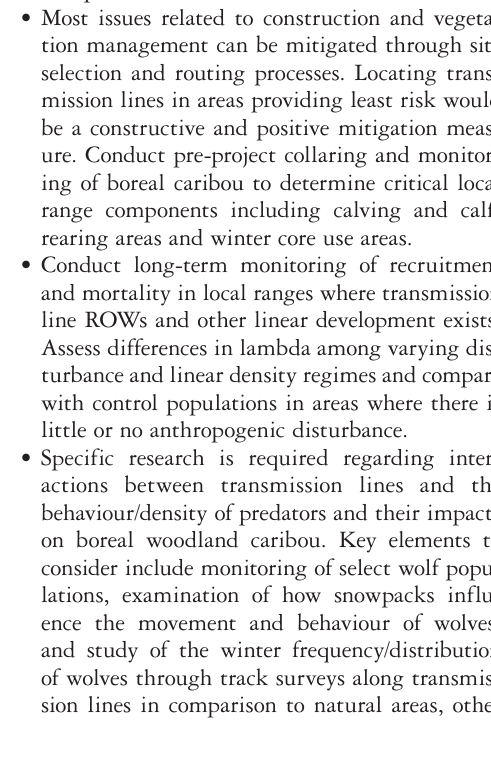
Table 5. Implications of threat categories for Site Selection and Environmental Assessment determined during Manitoba Hydro Boreal Woodland Caribou Workshop addressing hunting of boreal woodland